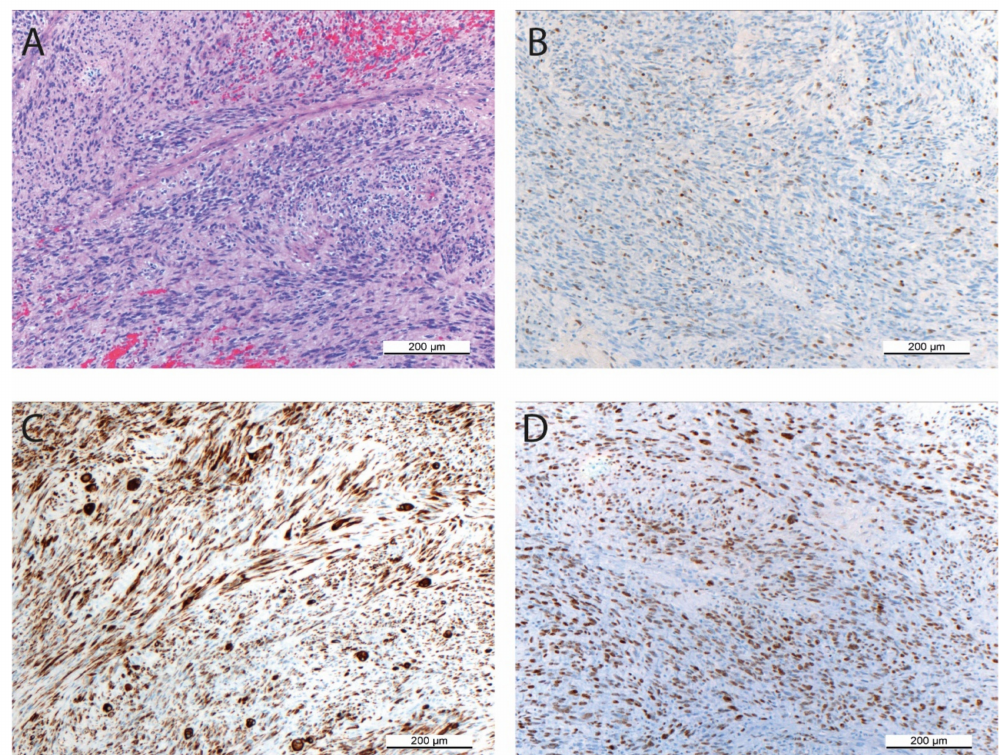
Figure 1. Histologic examination of the primary tumor from which the SRH cell line was established. ( A ) H&E staining (100 × magnification) showing the spindle cell morphology with scattered larger tumor cells mainly organized in fascicular patterns. ( B ) KI-67 positivity indicating proliferation activity was analyzed by immunohistochemistry (100 × magnification). ( C ) Desmin expression was determined by immunohistochemistry (100 × magnification). ( D ) Nuclear MYOD1 reactivity was evaluated by immunohistochemistry (100 ×